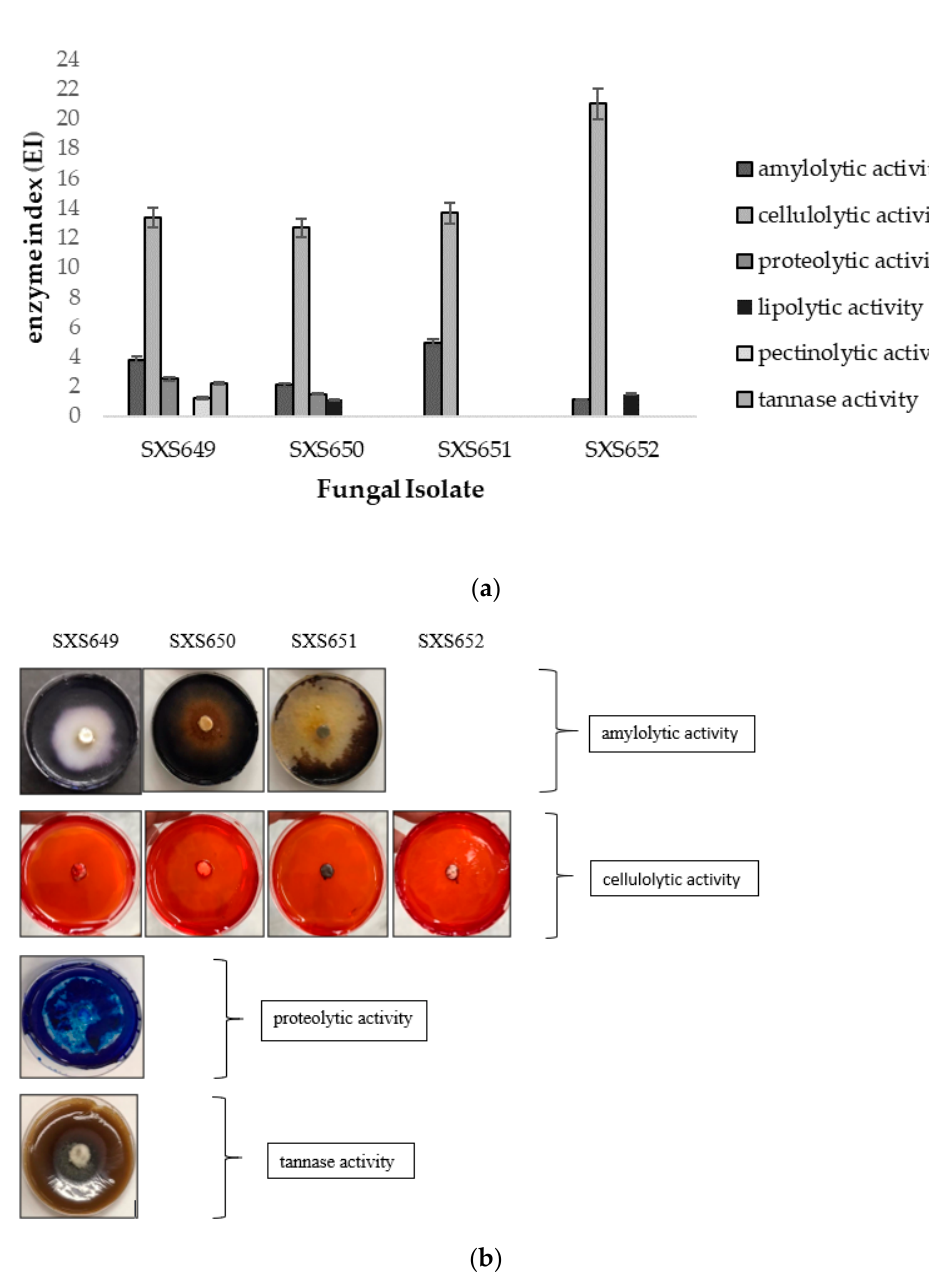
Figure 3. Enzymatic profile of the endophytic fungi Colletotrichum sp. SXS649, Pestalotiopsis sp. SXS650, Botryosphaeriales SXS651, and Diaporthe sp. SXS652 isolates from P. rigida Kunth. ( a ) Enzyme index (IE). Values correspond to the average of 3 repetitions: ( b ) Cultures in specific media showing the substrate degradation halo as indicative of enzymatic activity.